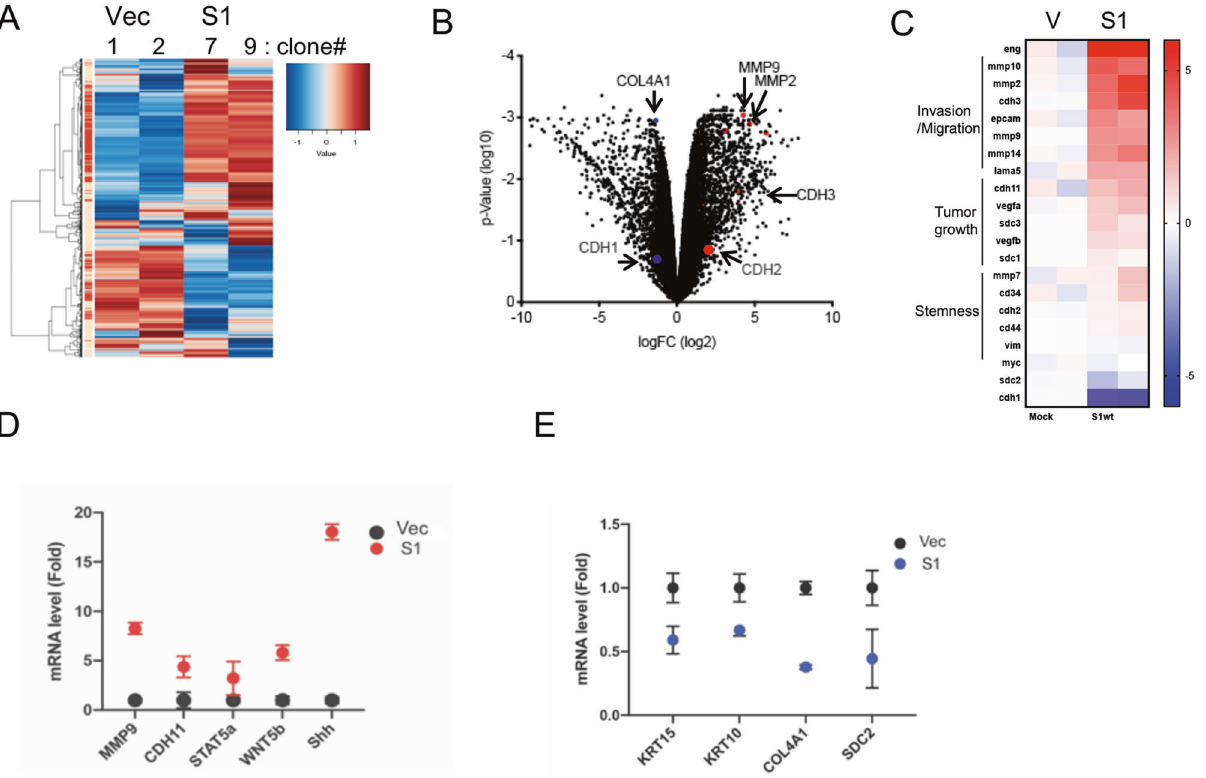
Fig. 4 SENP1 overexpression increases the expression of cell invasion-related genes in 786-O cells. he heatmap ( A ) and volcano graph ( B ) of RNA-seq data from two different ccRCC cell clones for each group (vector or SENP1 overexpressing cells) are shown for mRNA expression with ≥ 2-fold changes with signi fi cance at ( p < 0.05). The red and blue dots in the volcano graph highlight several genes displaying differences. C Heat map showing clusters of malignancy-related genes from RNA-seq analysis from ( A ). mRNA levels of select genes from C were analyzed by qRT-PCR. The graphs show the fold change as mean ±SEM. RNAs increased are shown in red ( D ) and those decreased are shown in blue ( E